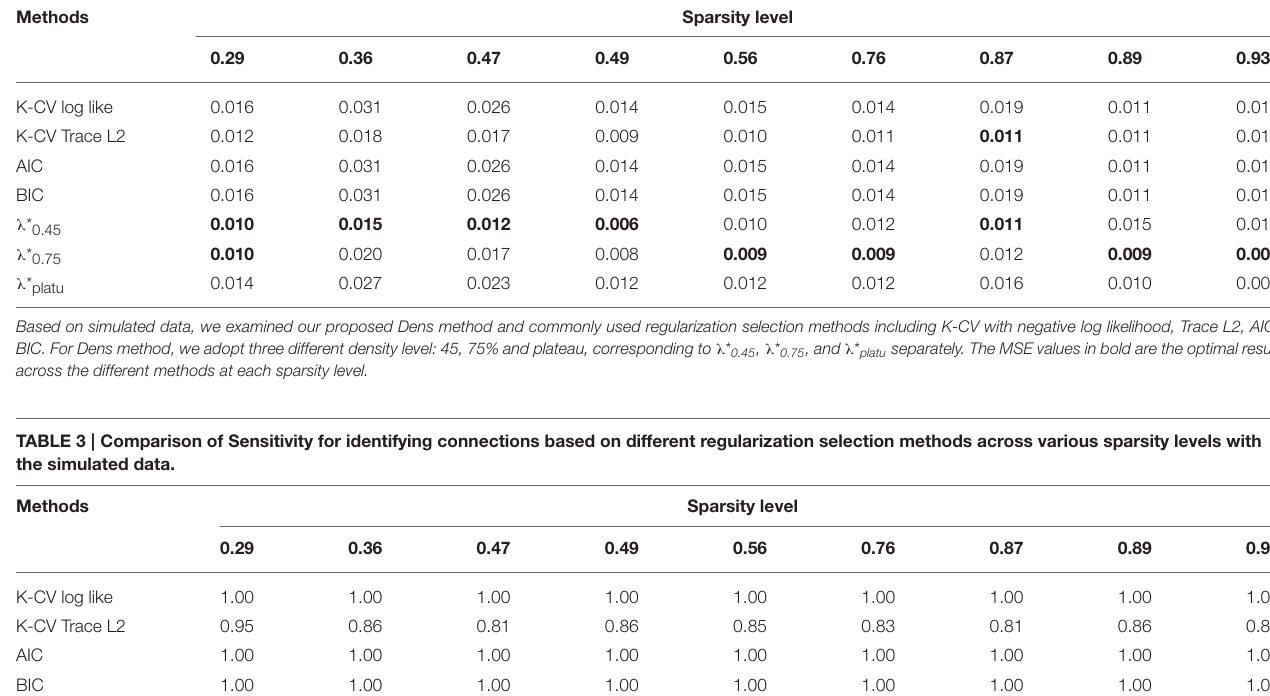
TABLE 2 | Comparison of MSE for estimated partial correlation matrix based on different regularization selection methods across various sparsity levels with the simulated data. Methods